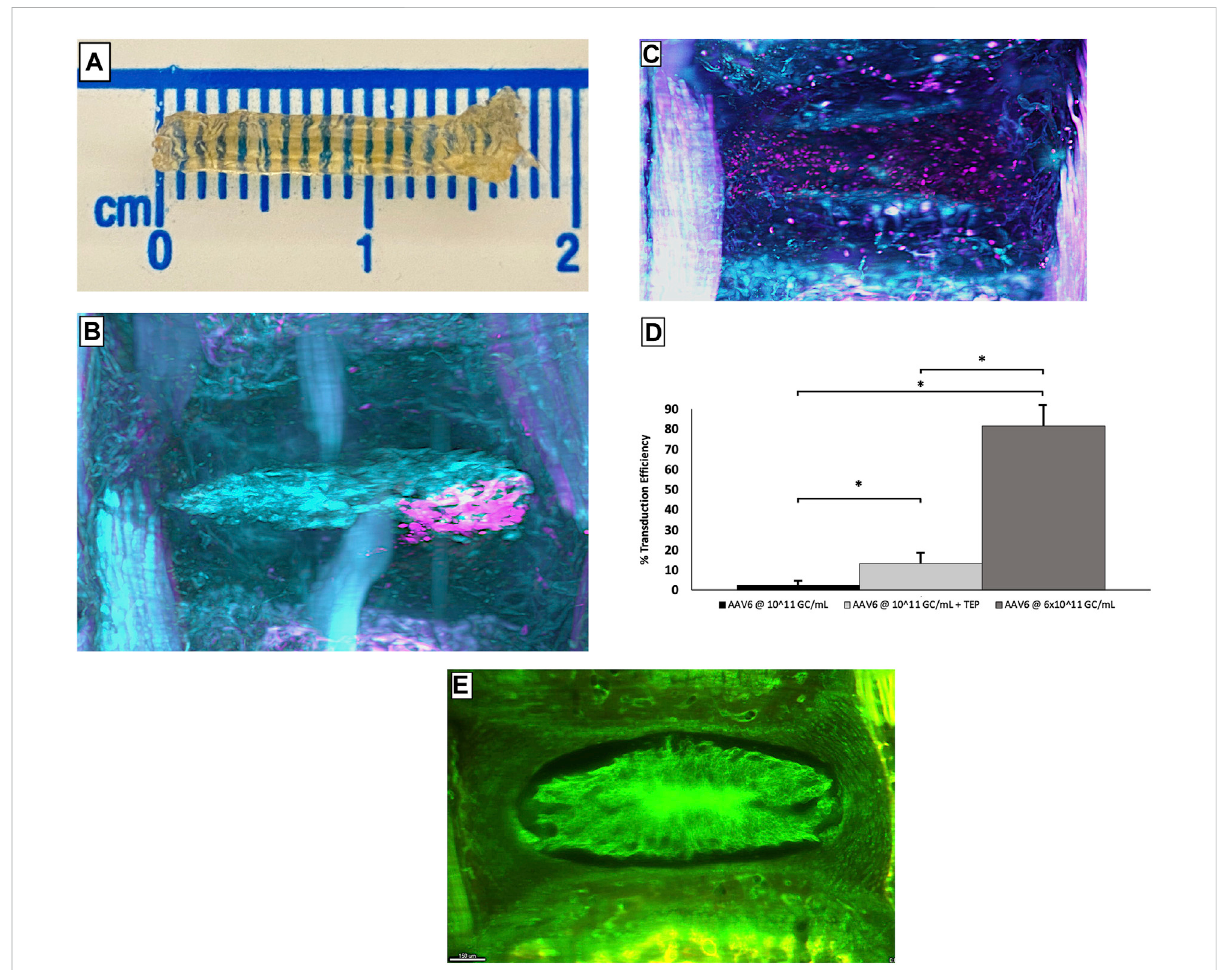
FIGURE 2 Complete mice caudal spines obtained using the PEGASOS method (A) . The images of the caudal tissues transferred by AAV6 alone (B) and AAV6+cell-permeable peptide (C) are viewed using 3D lightsheet microscopy, pink represents cells that transduced successfully, and cyan represents cells that transduced failed. Statistical analysis of the number of NP cells successfully transduced under each condition (D) . The representative image of IVD tissue without punctured (E) . Error bars show SEM. ‘ p ’ means p < 0.05, indicating a statistical difference. Reprinted permission by CC BY license (Kim et al., 2022).